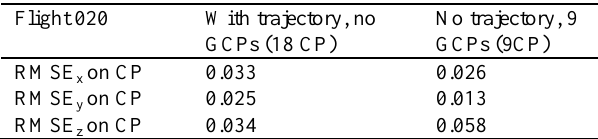
Table 1: RMSEs (in m) for flight 020, 2.4 cm GSD.